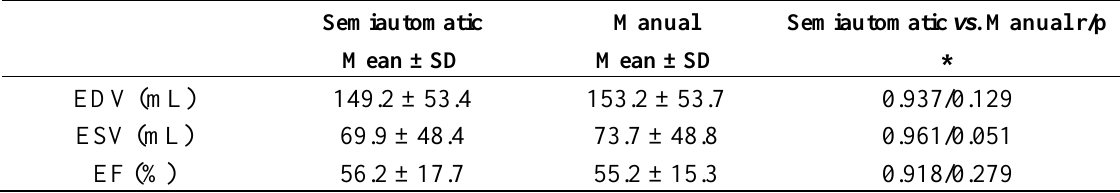
Table 1. Quantification of left ventricular parameters using semiautomatic and manual segmentation